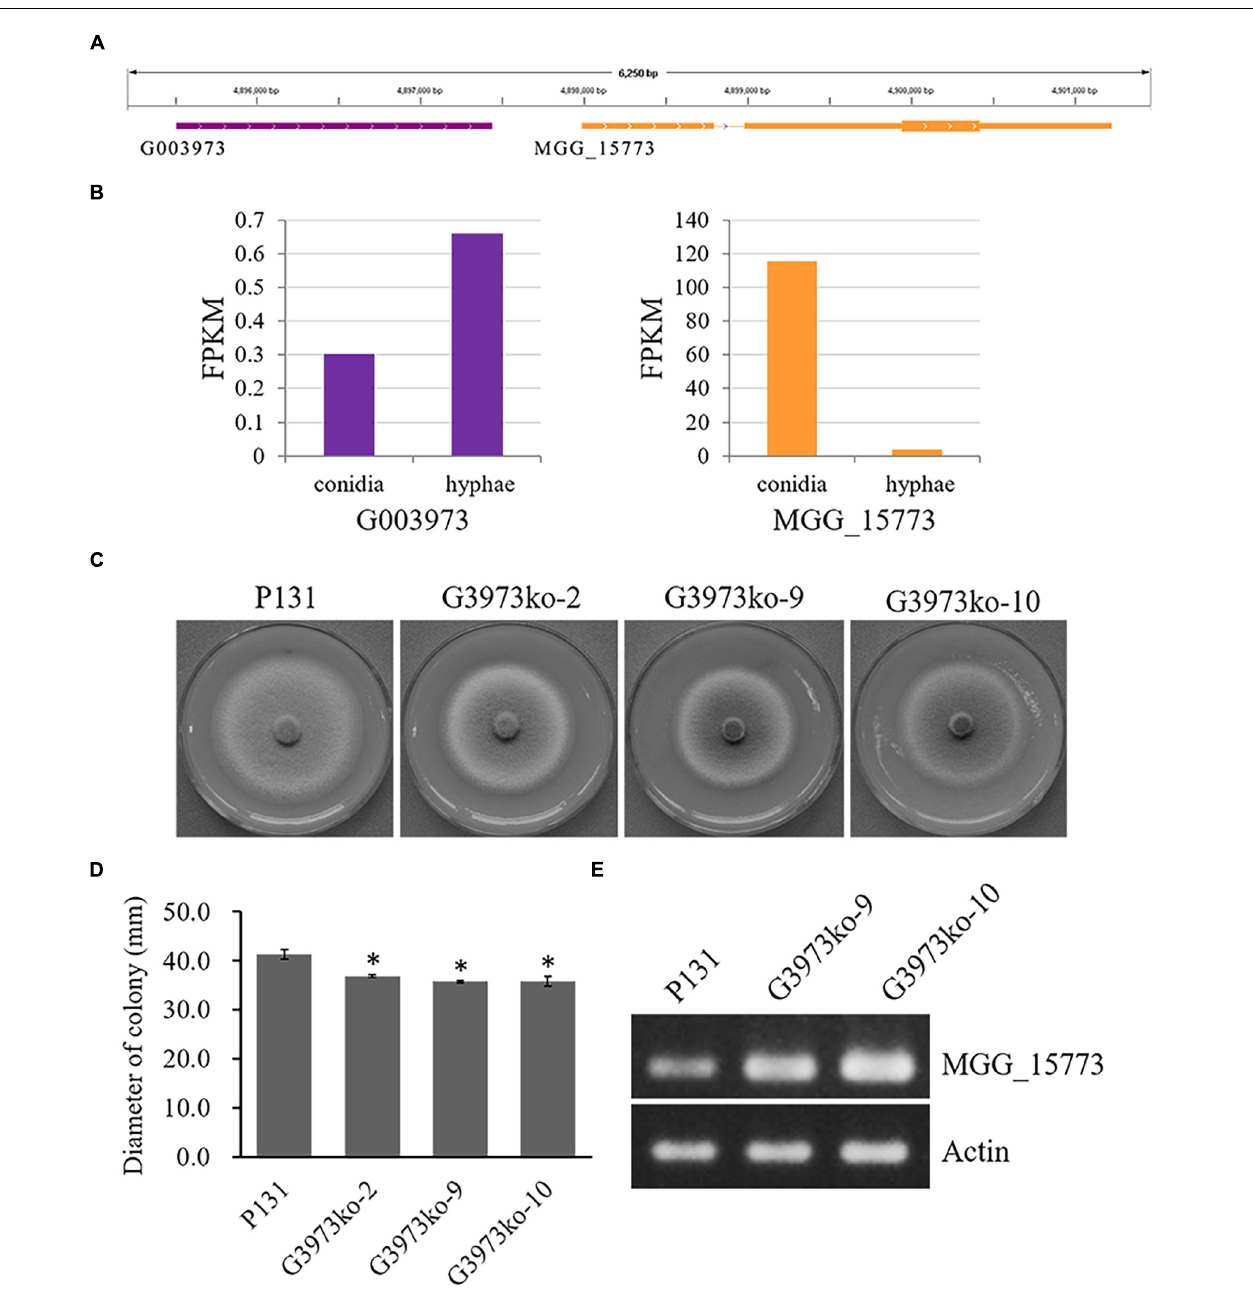
FIGURE 5 | The G003973 lncRNA is important for colony growth. (A) The G003973 lncRNA was 544 bp upstream from MGG_15773. (B) The expression levels of G003973 and MGG_15773 in conidia and hyphae, respectively. (C) Colonies of the wild-type strain P131, the G003973 deletion mutants G3973ko-2, G3973ko-9, and G3973ko-10 on OTA plates at 5 dpi. (D) Bar graphs showing the diameters of colonies P131, G3973ko-9, and G3973ko-10 on OTA plates at 5 dpi. Means ± SE were calculated from three independent replicates. ∗ P < 0.01 (Student’s t -test). (E) Expression levels of MGG_15773 in strains P131, G3973ko-9, and G3973ko-10, and the actin gene was used as a